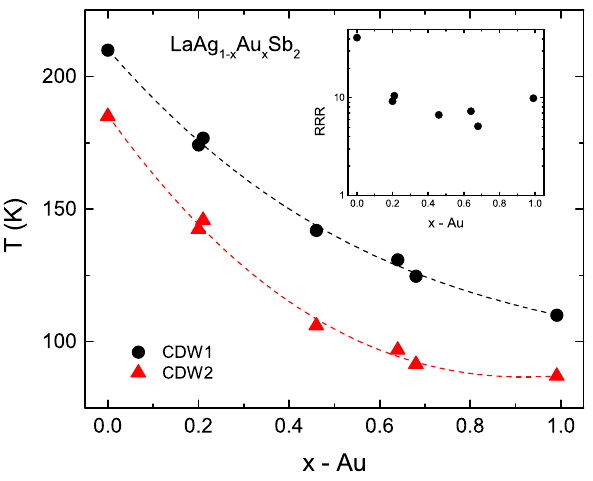
Figure 6. Transition temperatures, CDW1 and CDW2, as a function of x in LaAg 1 − x Au x Sb 2 . Data are vertically shifted for clarity. Dashed lines are guide for the eye. The inset shows residual resistivity ratio, RRR = ρ ab ( 300 K ) / ρ ab ( 1.8 K ) as a function of x